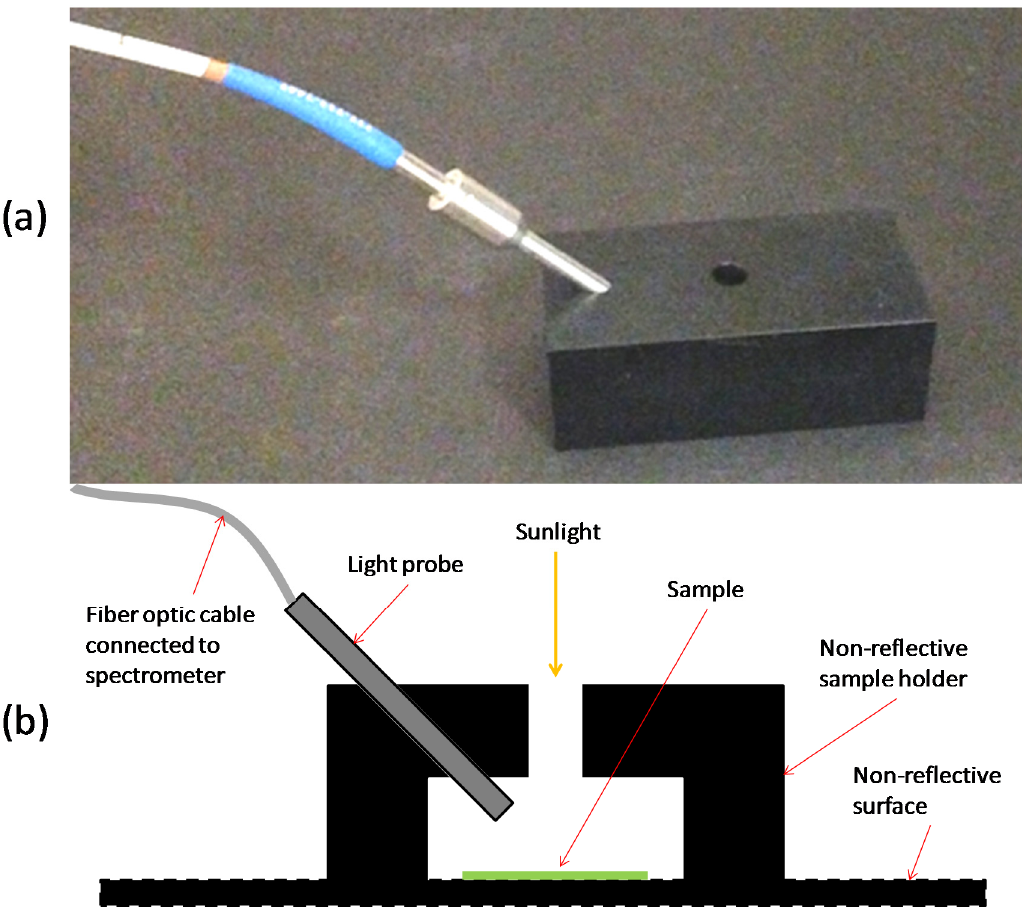
Figure 1. Reflection probe holder allowing the sun’s radiation to be focused on a 10 mm diameter circular section of the sample and for the response to be detected at a 45° angle using a fiber optic probe and cable connected to a spectrometer. ( a ) Picture of the apparatus; ( b ) schematic of the cross-sectional area.